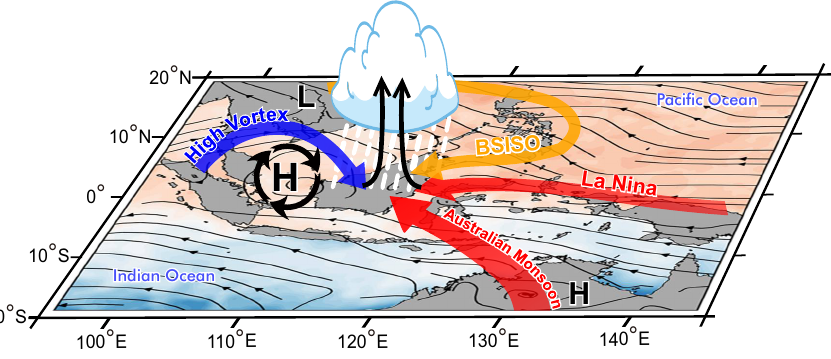
Figure 11. A conceptual diagram depicting the role of atmospheric modes in the variability of the moisture source regions during the flood event over Nusantara on 27–28 August 2021. Color shading denotes